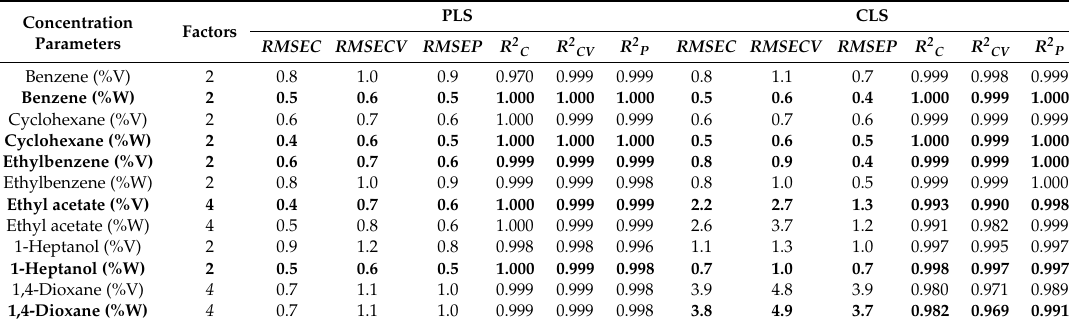
Table 1. The calibration and test results obtained with PLS and CLS regressions of the NIR spectra of system 1 and system 2 based on %V and %W concentrations (the bold values highlight the higher-quality results with reference to the concentration